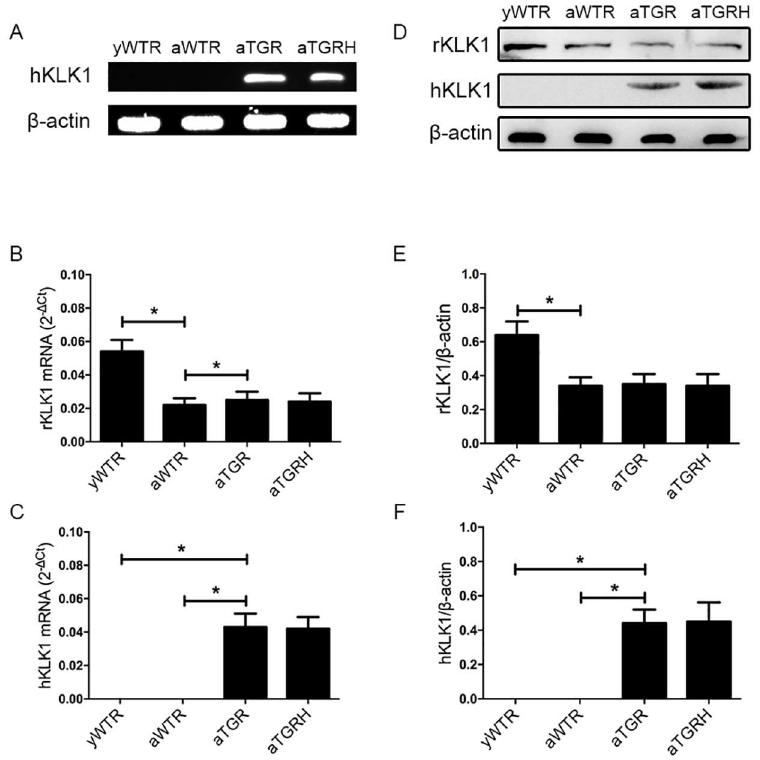
Fig 2. Verification of presenceand expressionof hKLK1 and rKLK1 genes in the corpus cavernosum. (A): Representative hKLK1 genomicsDNA bands in rats’ corpus cavernosumby agarosegel electrophoresis followedby conventional PCR. (B) and (C): RelativemRNA expressions of hKLK1 and rKLK1 with β -actinas the loadingcontrol in corpus cavernosum of rats in all groupsby RT-PCR using the 2- Δ Ct method. (D), (E) and (F): Expressions of hKLK1 and rKLK1 in the corpus cavernosumof rats in all groupsby western blot analysis. The data are expressedas mean ± s.d. * P < 0.05when comparingthe two groupsunder each end of the